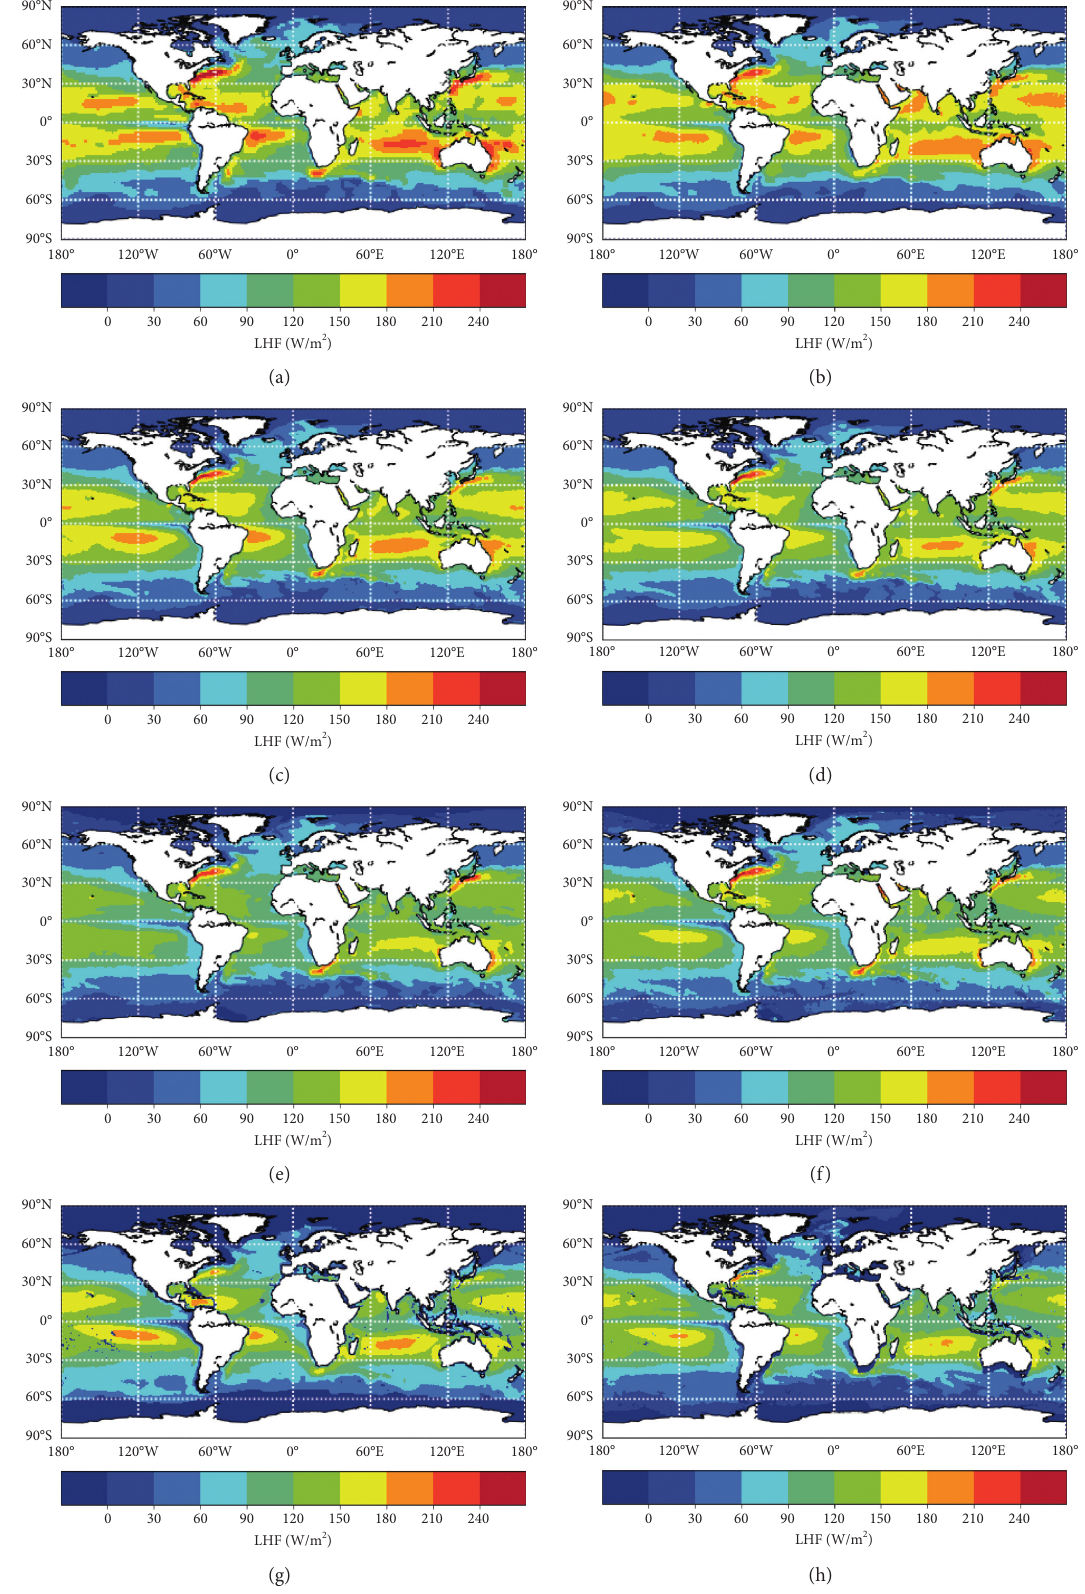
Figure 6: Maps of climatology LHF values derived from 8 products averaged from 2003 to 2007: (a) NCEP-2; (b) JRA-25; (c) MERRA-2; (d) ERA-I; (e) OAFlux; (f) J-OFURO; (g) GSSTF-3; (h)